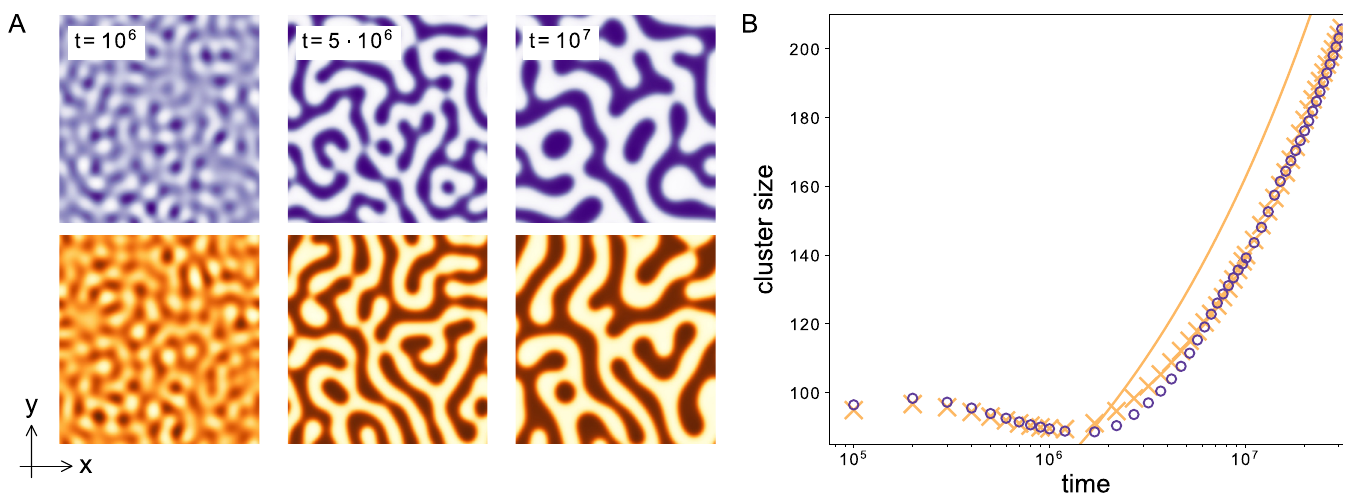
Fig 4. Comparison of the dynamics of the polarization model and its corresponding CH model. (A) 2D snapshots of the full model (upper row, purple) and the corresponding CH model (bottom row, orange) for different times. The Cahn-Hilliard model captures the coarsening dynamics of the full model. (B) Cluster size as a function of time for the polarization model (purple circles) and the corresponding CH model (orange crosses). The solid orange line shows the power law that is expected as a long-term behavior. Parameters: a 2 = 2, ε = 0.01.